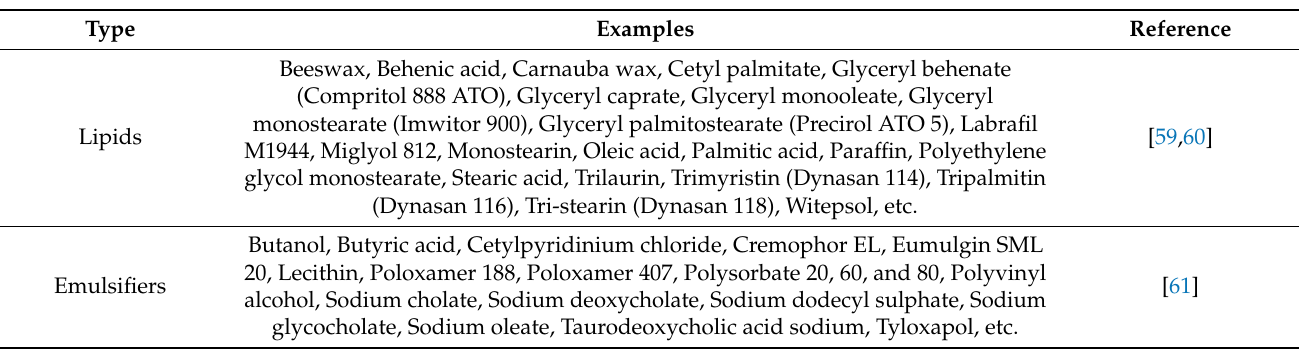
Table 1. Structural components of solid-lipid